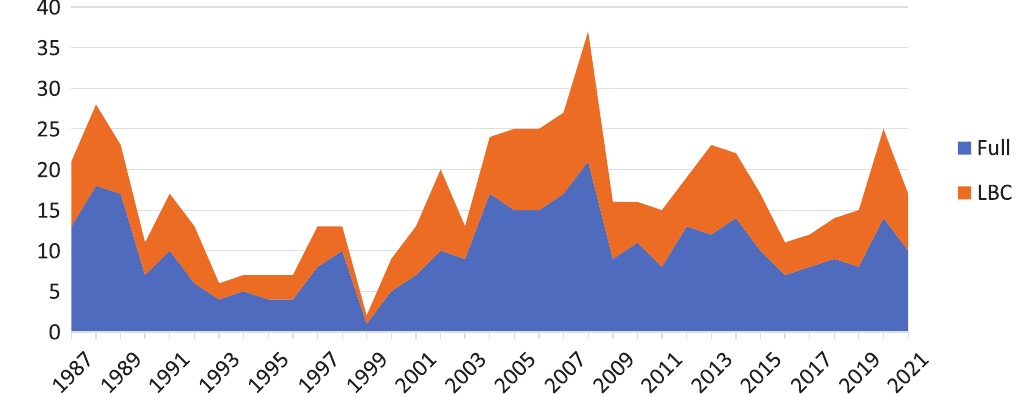
Figure 3. Volume of full (planning permission) and LBC major applications between 1987–2021 in the HCCA. Urban Planning, 2023, Volume 8, Issue 1, Pages